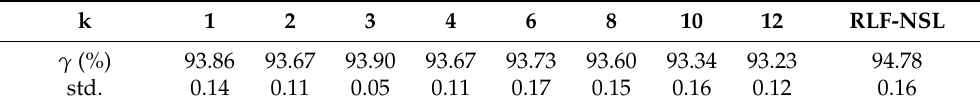
Table A2. The classification accuracy γ and the standard deviation (std.) on the MNIST dataset for N = 600 by KNN with different k and by the RLF-NSL with β = 1.35.